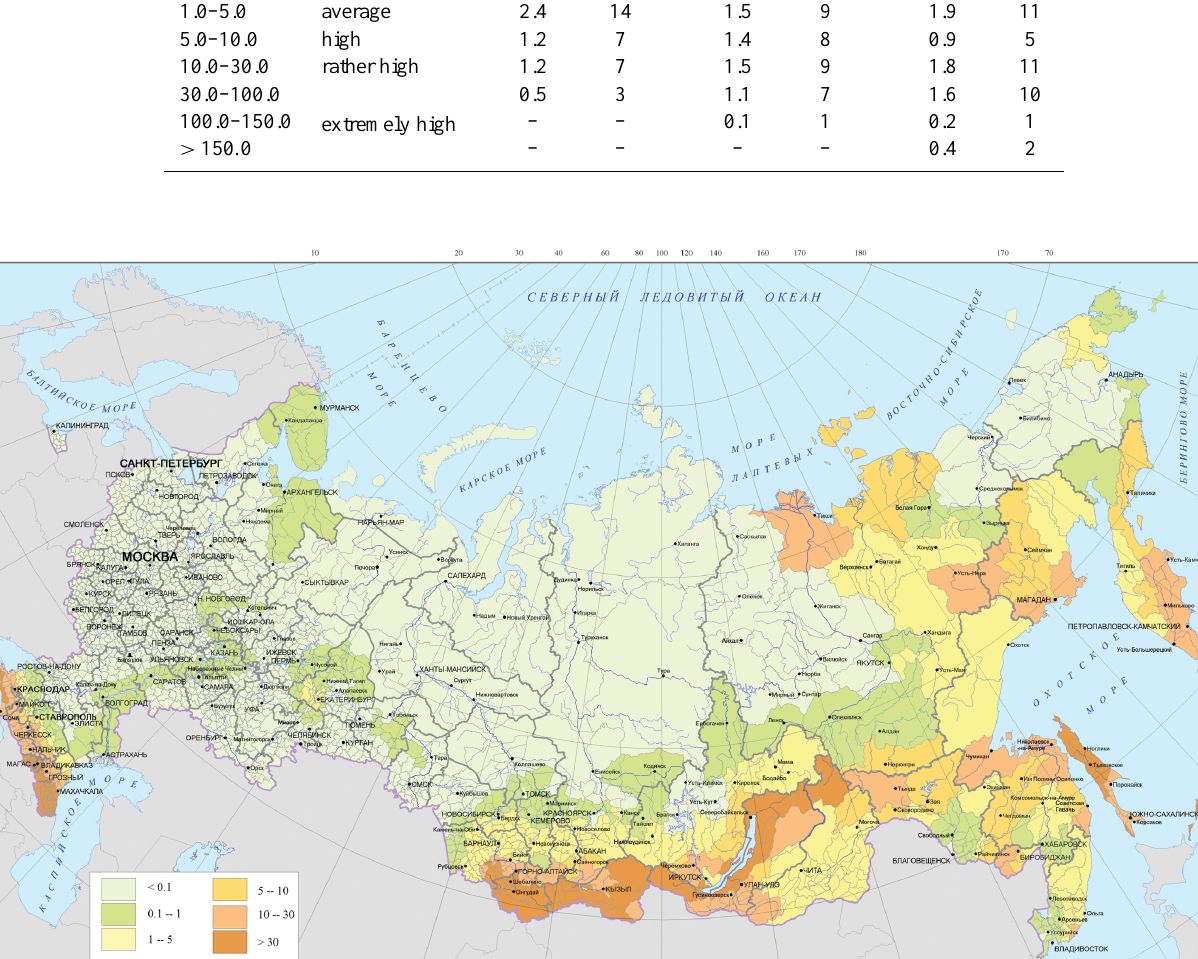
The computed values of individual seismic risk R s 1 are more than 30 × 10 − 5 yr − 1 for all administrative